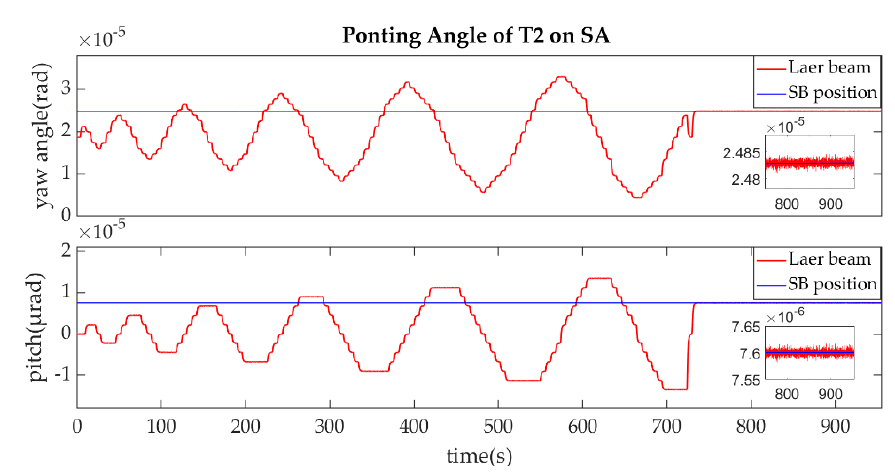
Figure 15. Pointing Angle of T2 on SA.